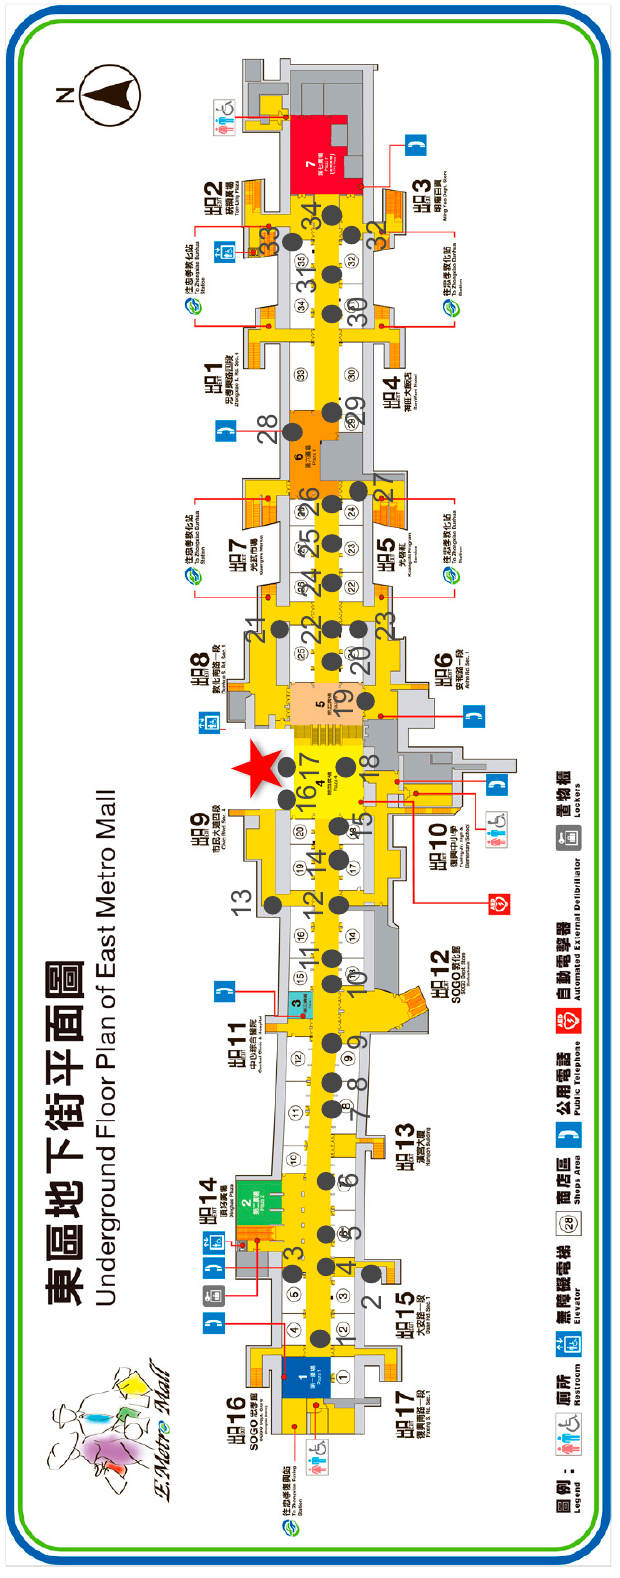
Figure 20. The distribution of the sensors and the gateway of the real-world experiment.